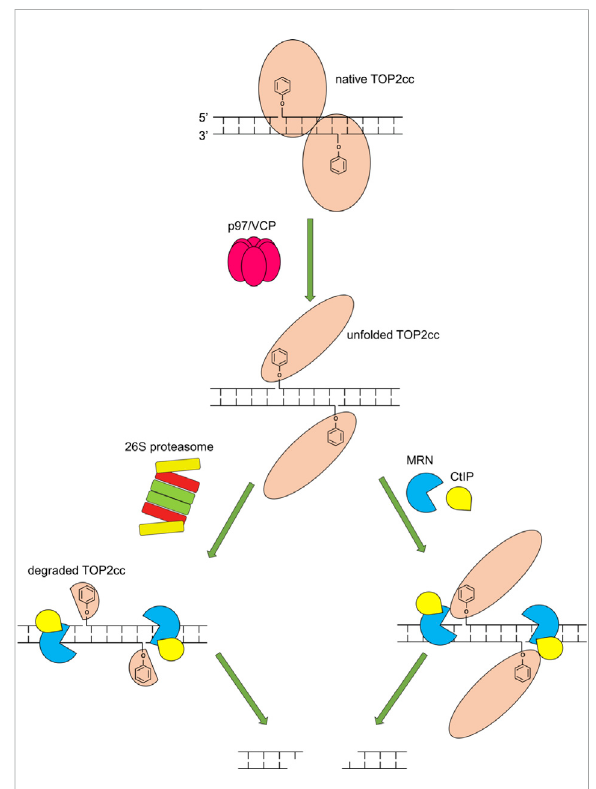
Model of requirements for the MRN complex to repair TOP2cc. Upon trapping of a TOP2cc, VCP/p97 is recruited and unfolds the TOP2cc, enabling the 26S proteasome (left) and the MRN complex and CtIP (right) to process the TOP2cc. The MRN complex in cooperation with CtIP incises the vicinity of the TOP2cc using its single-strand endonuclease activity, releasing the TOP2cc and liberating the otherwise TOP2-linked DSB (the release may require Mre11 3 ′ -5 ′ exonuclease activity following its endonucleolytic incision). Proteolytic degradation of TOP2cc by the 26S proteasome may facilitate the nucleolytic processing by the MRN complex and